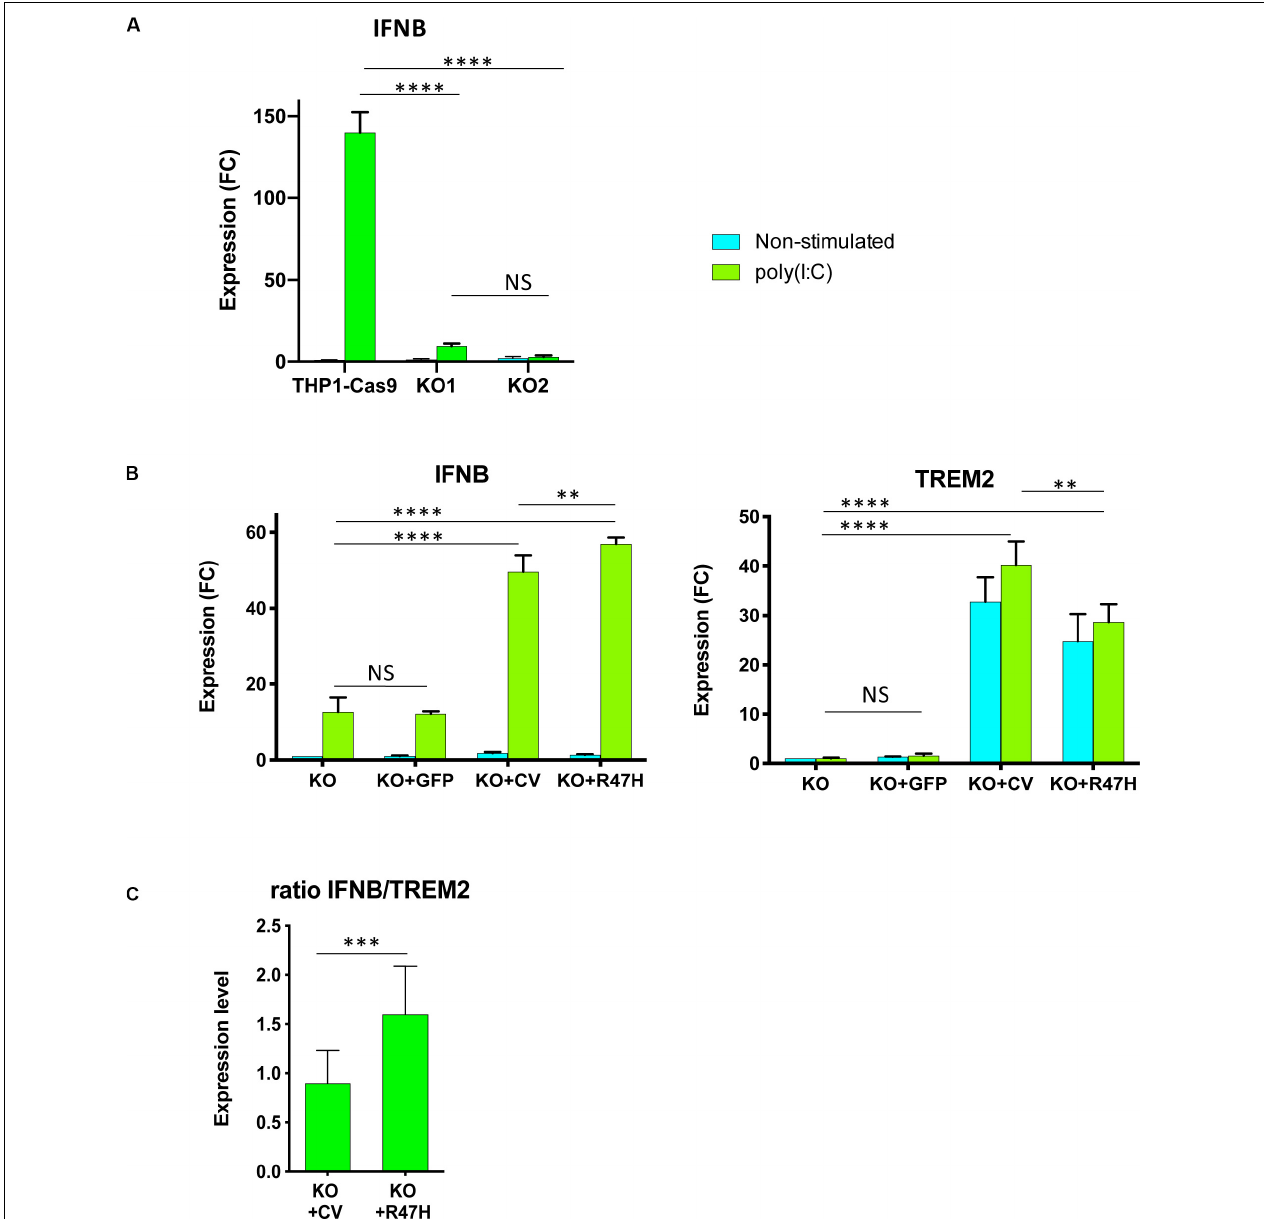
FIGURE 7 | TREM2 stimulates IFN I response in THP1 cells. (A) Absence of TREM2 inhibited IFN I response in THP1 TREM2 KO. IFNB expression in non-stimulated cells and after 24 h with poly(I:C) complexes was measured by qRT-PCR. THP1-Cas9, THP1 stably expressing Cas9 nuclease; KO1, KO2 are two independent TREM2 KO clones. IFNB expression was normalized to the level in unstimulated THP1-Cas9. FC – fold changes. (B) Overexpression of TREM2, but not GFP, restored the IFN I response. Assays were performed in biological triplicates and repeated at least two times; (A,B) show representative experiments. KO – TREM2 KO1 cells; KO + GFP – TREM2 KO1 expressing GFP; KO + CV – TREM2 KO1 expressing common variant (CV) TREM2; KO + R47H – TREM2 KO1 expressing R47H TREM2. All cells were treated with doxycycline. TREM2 and IFNB expression was normalized to their levels in unstimulated KO. (C) Expression of R47H TREM2 induced a higher level of IFNB as compared with CV TREM2. Ratio of IFNB to TREM2 expression was calculated for TREM2 KO1 THP1 expressing either CV TREM2 or R47H TREM2 after 24-h poly(I:C) treatment from eight independent biological replicates performed on different days. Data are presented as mean ± SD. Significance in (A,B) was calculated using two-way ANOVA, Tukey’s multiple comparison test; significance in (C) was calculated using an unpaired two-tailed t -test (NS, non-significant; ∗∗ p < 0.01; ∗∗∗ p < 0.001; and ∗∗∗∗ p <